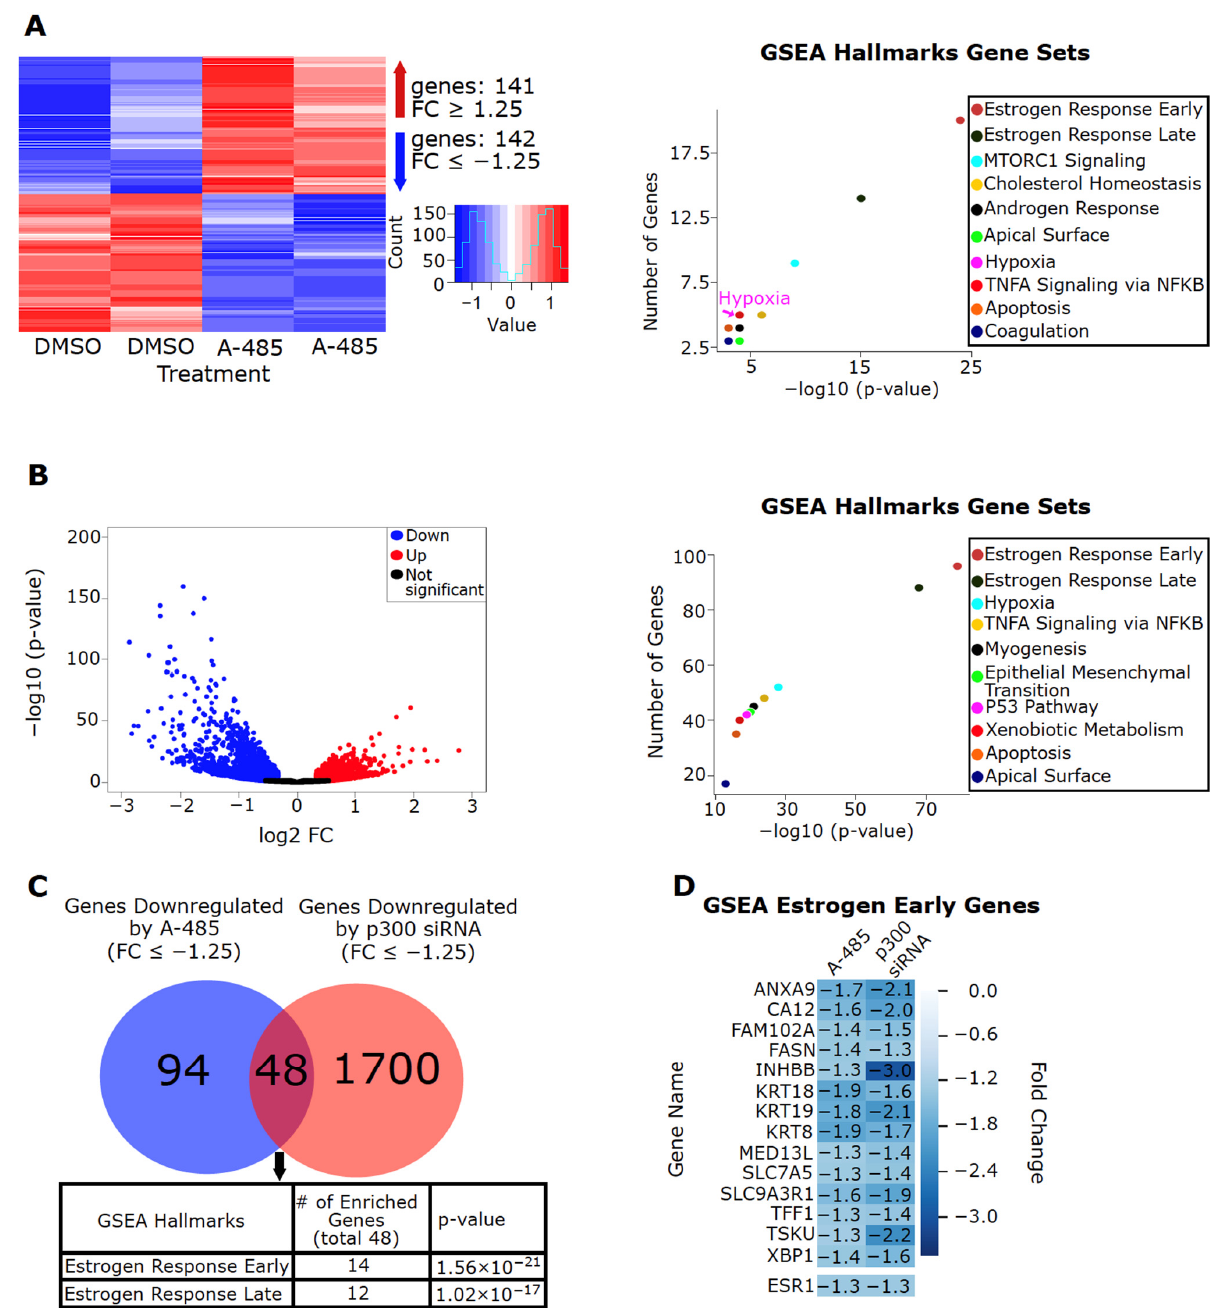
Figure 3. p300 is critical for the expression of estrogen-regulated genes in MCF-7 cells. ( A ) A-485 downregulates expression of estrogen-regulated genes in MCF-7 cells. Global gene expression in MCF-7 cells treated with A-485 (3 µ M) for 24 h was analyzed using microarray. A-485 upregulates 141 genes (FC ≥ 1.25, p < 0.05) and downregulates 142 genes (FC ≤ − 1.25, p < 0.05). The downregulated genes were analyzed for their involvement in biological pathways using GSEA Hallmarks Gene Sets. The top statistically enriched pathways are shown (right). ( B ) Genetic depletion of EP300 via siRNA downregulates expression of estrogen-regulated genes in MCF-7 cells. The log2 FC of all differentially expressed genes ( p < 0.05) are shown. The downregulated genes were analyzed for their involvement in biological pathways using GSEA Hallmarks Gene Sets. The top statistically enriched pathways are shown (right). ( C ) CBP/p300 KAT inhibitor A-485 and EP300 genetic depletion impair ER signaling similarly. The genes repressed by A-485 in ( A ) were compared to the genes downregulated by EP300 genetic depletion ( B ). Genes downregulated by both were analyzed for their involvement in biological pathways using GSEA Hallmarks Gene Sets. The top statistically enriched pathways are shown below. ( D ) Members of the GSEA Estrogen Early Hallmark Gene Set downregulated by both A-485 and EP300 genetic depletion are shown with their respective fold